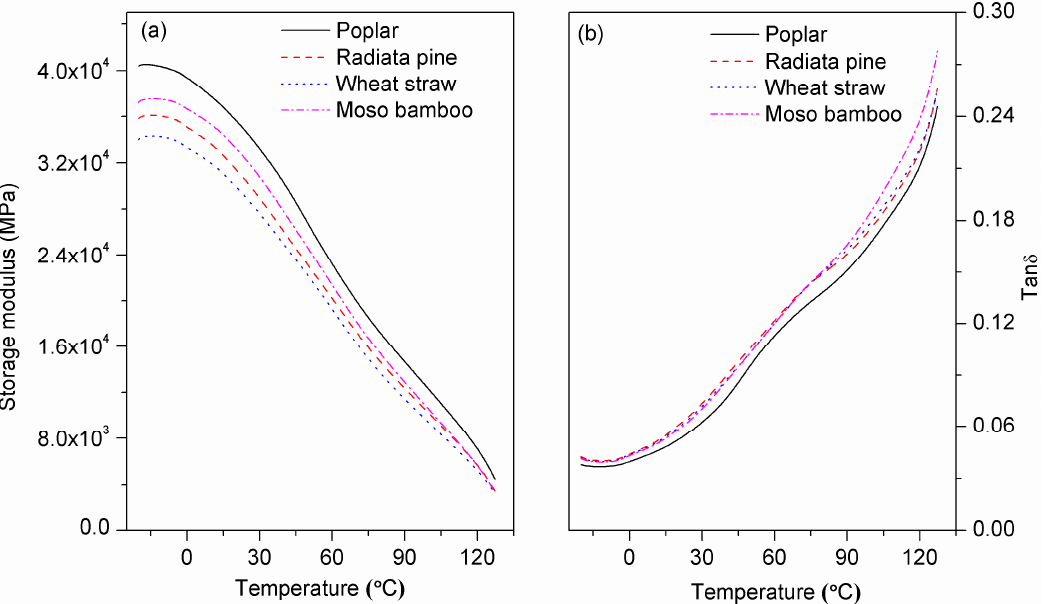
Figure 8. ( a ) Storage modulus and ( b ) tan δ of the composites with different biomass species.